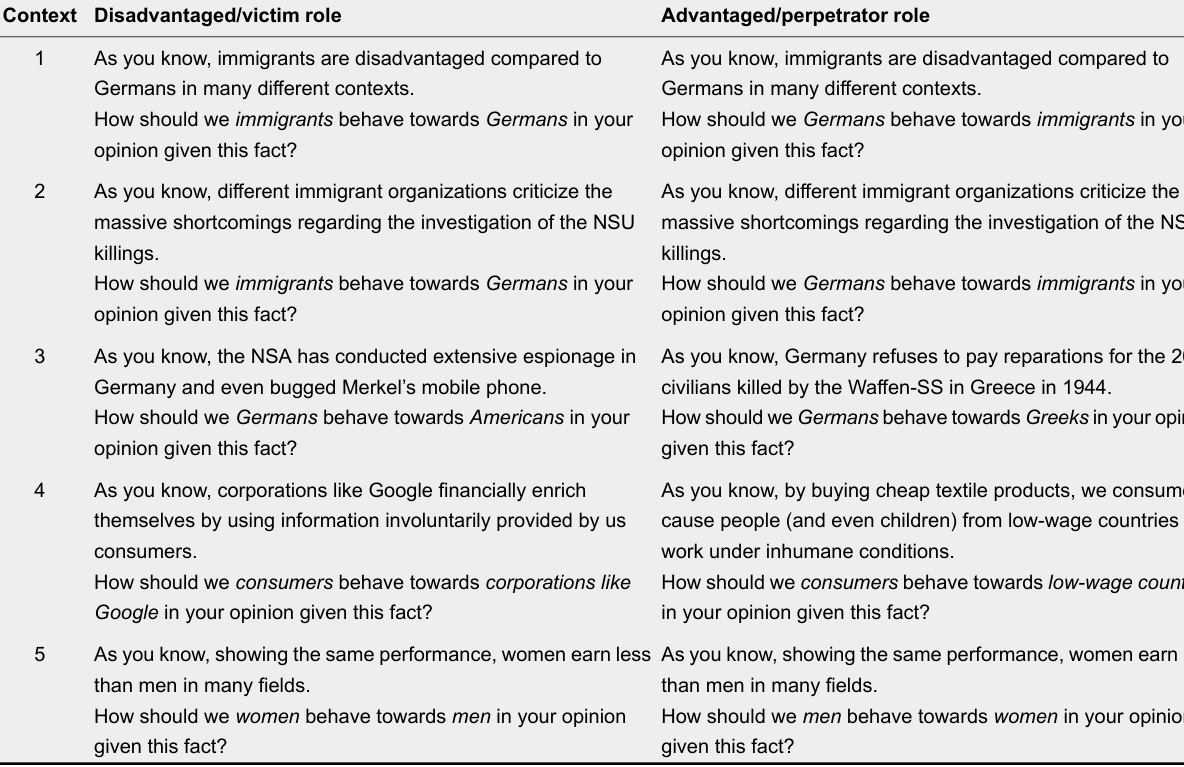
Social Role Manipulations (CSIG Instructions) Used in Study 1